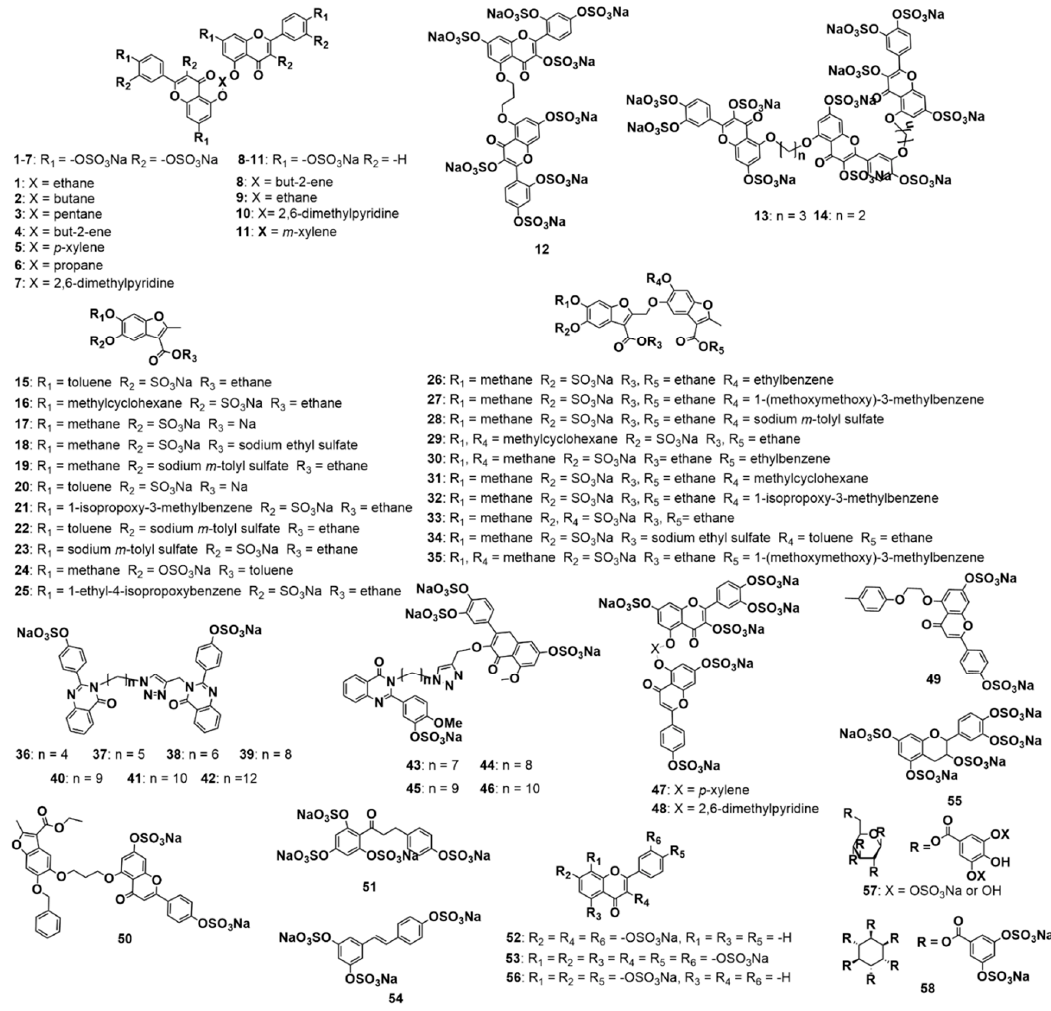
Figure 1. Structures of the 58 non-saccharide glycosaminoglycans (GAGs) mimetics (NSGMs) studied against MMP-8. The synthesis and characterization of these molecules has been